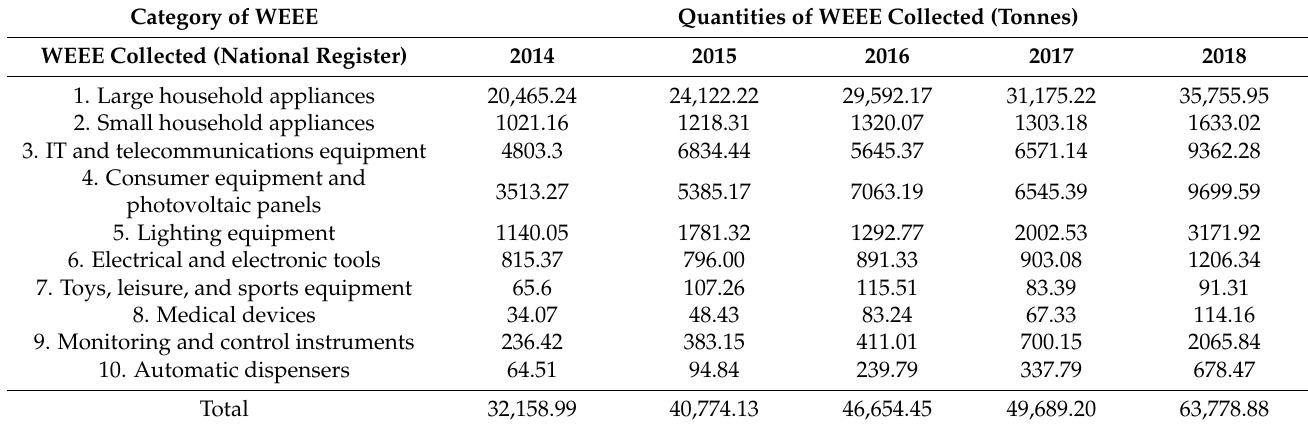
Table 2. E-waste generated in Romania during 2014–2018, according to the National Agency for Environmental Protection